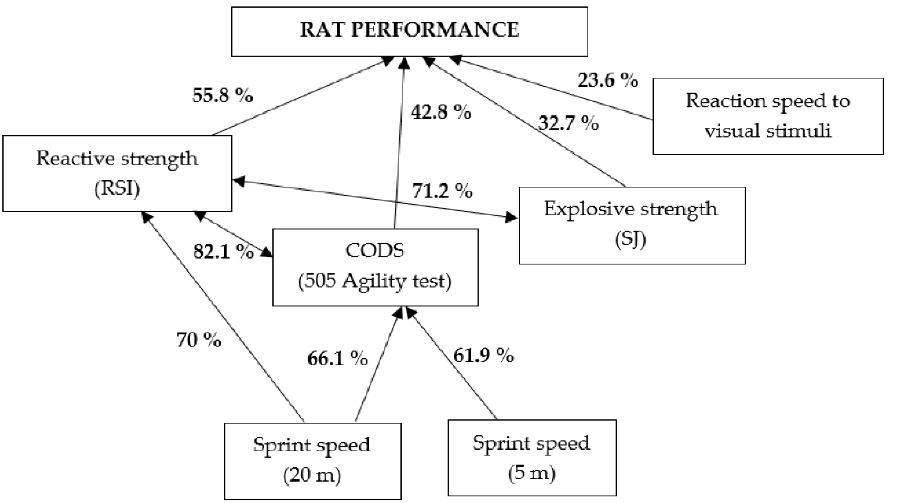
Figure 2. Percentual contribution of factors that determined the RAT performance based on the coefficients of determination for handball players